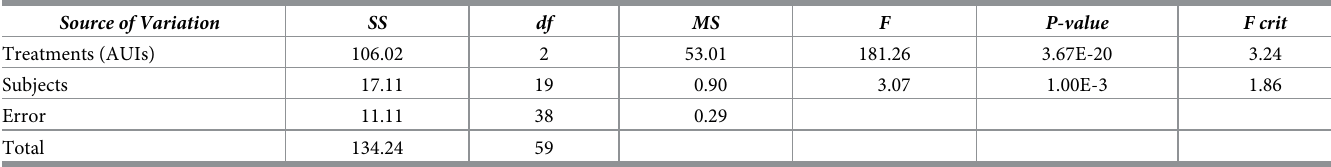
Table 8. Repeated-measures ANOVA—Group #3.